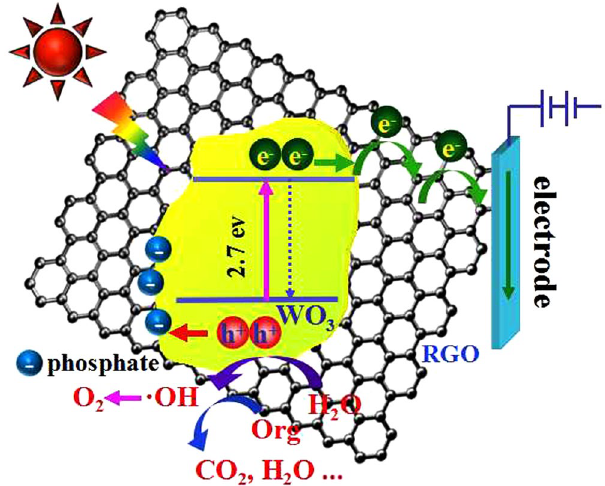
Figure 6. Schematic mechanism of WO 3 co-modified with RGO and phosphate as a photoanode for PEC water oxidation to evolve O 2 and pollutant